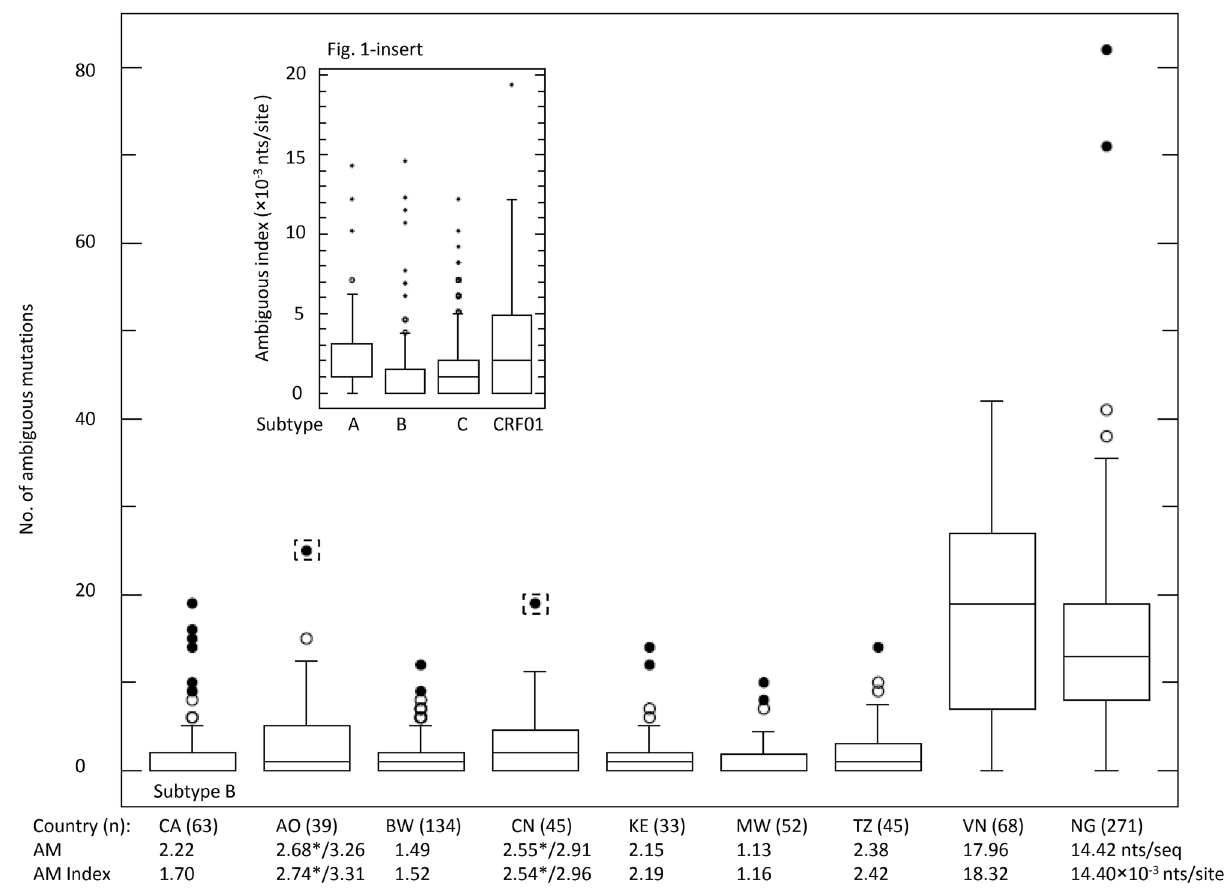
Figure 1. Descriptive statistics of ambiguous mutation in various sequence datasets. Plot of ambiguous mutations with descriptive statistics was performed using online statistical tool (http://www.physics.csbsju.edu/stats/). Individual country dataset was described for minimal and maximal ranges (short horizontal line at the bottom and top of the box), interquartile range (IQR, at 1 st to 3 rd quartile, box), median (line inside box), suspected outlier (open dot), and outlier (solid dot). Number in the bracket is the number of sequences from the country, Angola (AO), Botswana (BW), China (CN), Kenya (KE), Malawi (MW), Tanzania (TZ), Vietnam (VN), Nigeria (NG), and Canada (CA) [24]. Numbers with asterisk were calculated without the outlier in dash square box. Figure 1-insert shows the descriptive statistics of ambiguous mutation index in the dataset based on subtype (Table 3). doi: